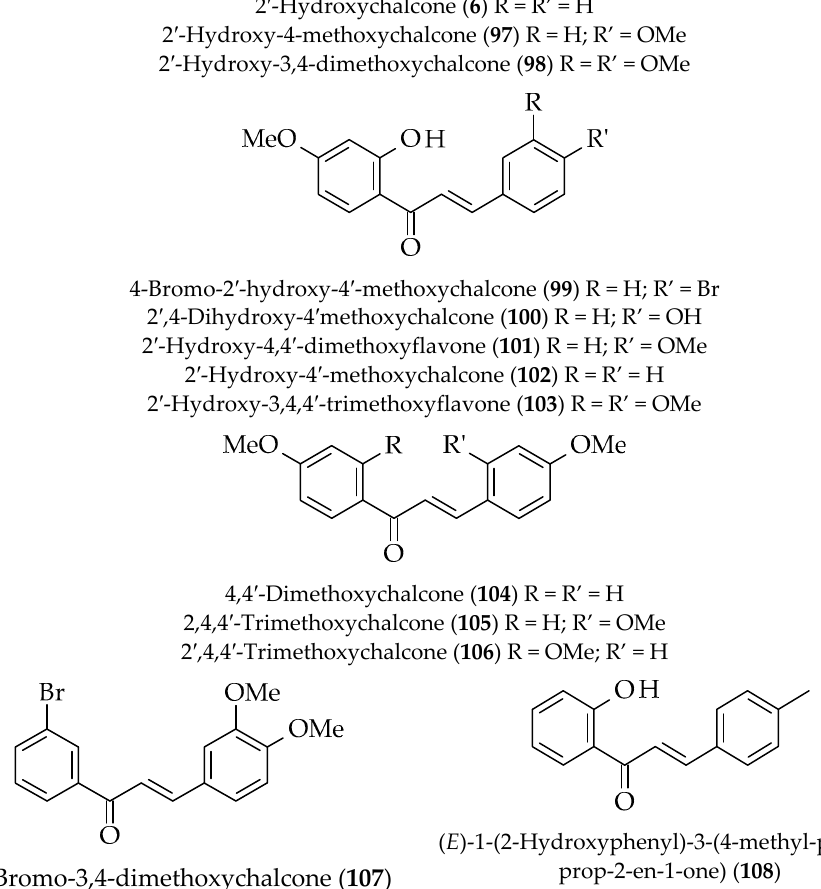
Figure 11. Structures of some synthetic chalcones with anticancer potential.